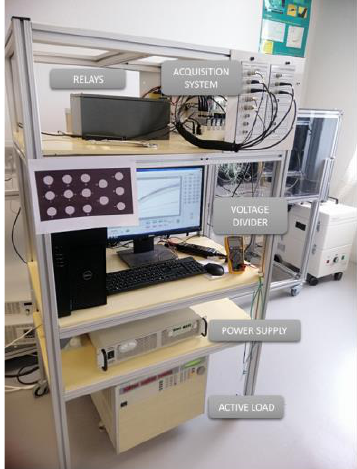
Figure 2. Power supply and data acquisition system.